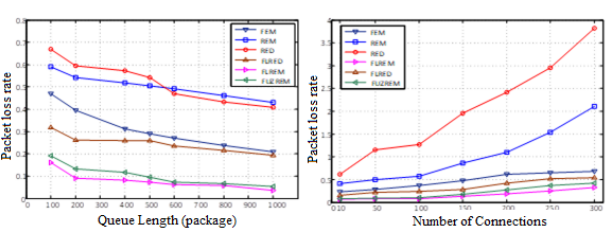
Figure 17. Packet loss rate of AQM mechanisms On the graph, the lines represent the packet loss rate of the mechanisms with partitioning into three groups. The top group belongs to the mechanisms that do not use fuzzy control (RED, REM), the group immediately below is the RED improvement mechanisms (FEM, FLRED), the bottom group is of the improved mechanisms. REM (FUZREM, FLREM).